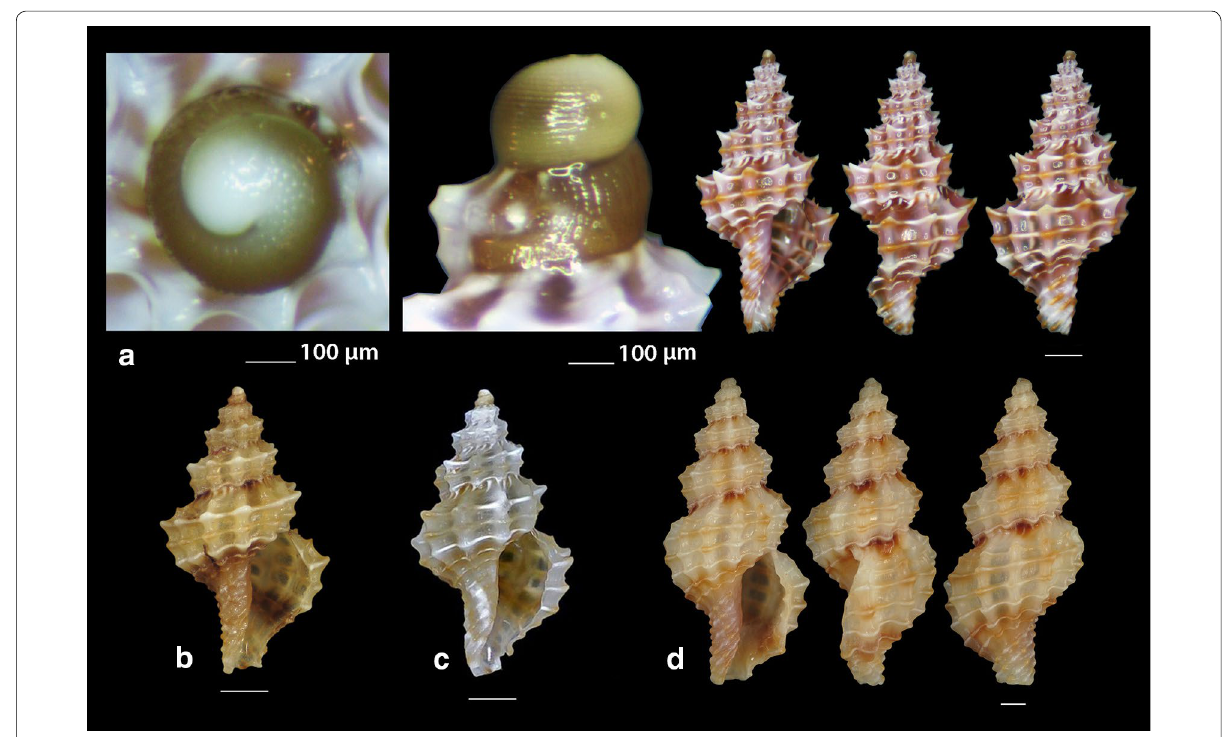
Fig. 12 a – d Raphitoma horrida . Bar